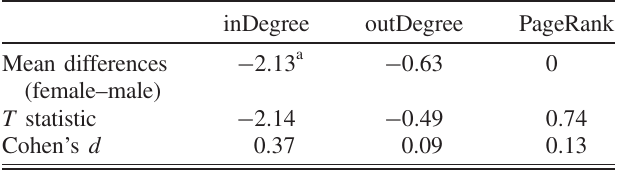
TABLE III. Gender-based comparisons of network centrality. InDegree and PageRank centralities do not differ significantly by gender. On the other hand, female students report more peers (i.e., outDegree) in response to the network survey question